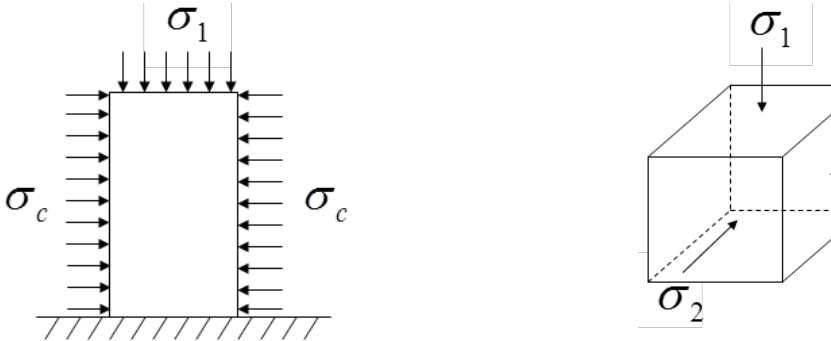
Figure 2. The rock sample under triaxial compression and the microscopic element, where σ 1 , σ 2 , and 𝜎 are the three principal stresses, and 𝜎 3